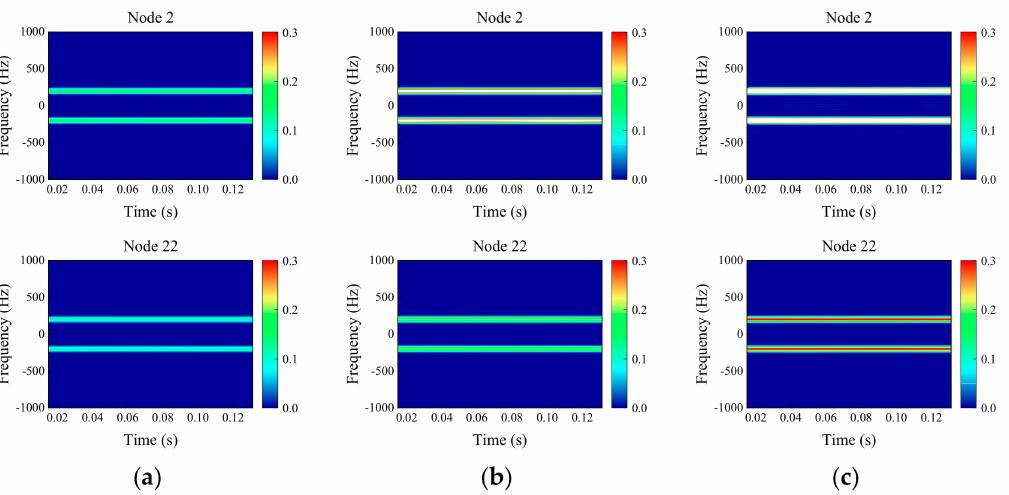
Figure 9. Time-frequency diagram of imbalanced and static eccentric coupling faults: ( a ) value of imbalance 20 × 10 − 5 kg · m; ( b ) value of imbalance 100 × 10 − 5 kg · m; ( c ) value of imbalance 200 × 10 − 5 kg · m.